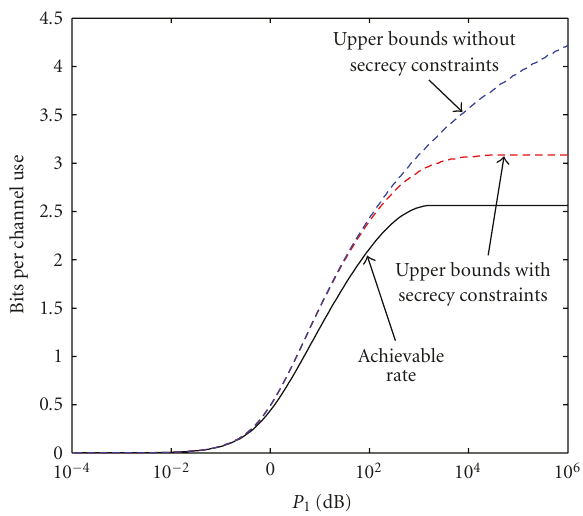
Figure 11: Secrecy Rate, P r = 40 dB, P 2 = 30dB, optimized over α , power control at the source node